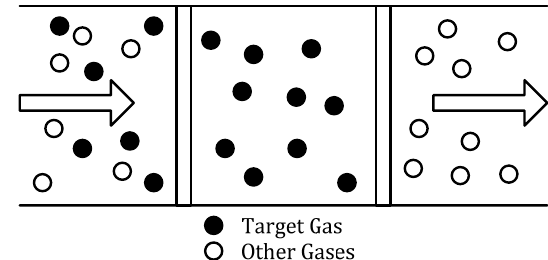
Figure 7. Absorption period of pre-concentration